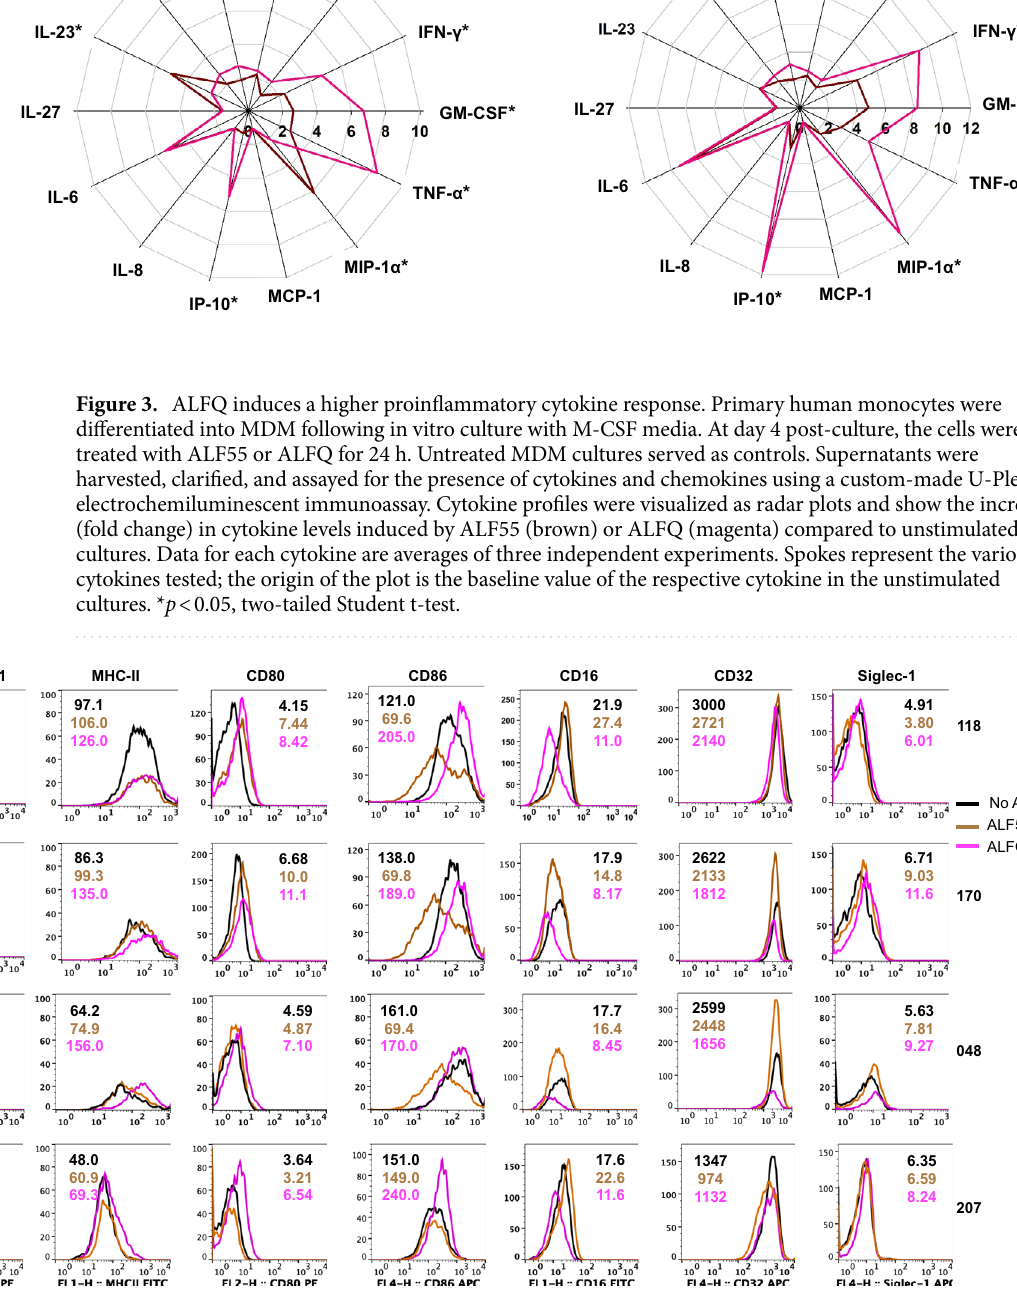
Figure 4. MDM exposed to ALFQ upregulate MHC-II and co-stimulatory molecules. Primary human monocytes were differentiated into MDM following in vitro culture with M-CSF media. At day 4 post-culture, the cells were treated with ALF55 or ALFQ for 24 h. Untreated MDM (no adjuvant) cultures served as controls. Cells were harvested, stained, and analyzed for the expression of MHC-I, MHC-II, CD80, CD86, CD16, CD32 and Siglec-1. Histogram overlays show the expression of the indicated cell receptor on the gated CD14 + MDM that were not treated with any adjuvant (black line) or were treated with ALF55 (brown line) or ALFQ (magenta line). Values shown inside the histograms are the mean fluorescent intensity (MFI) of the specific stain. Data are representative of triplicate wells of two independent experiments for four